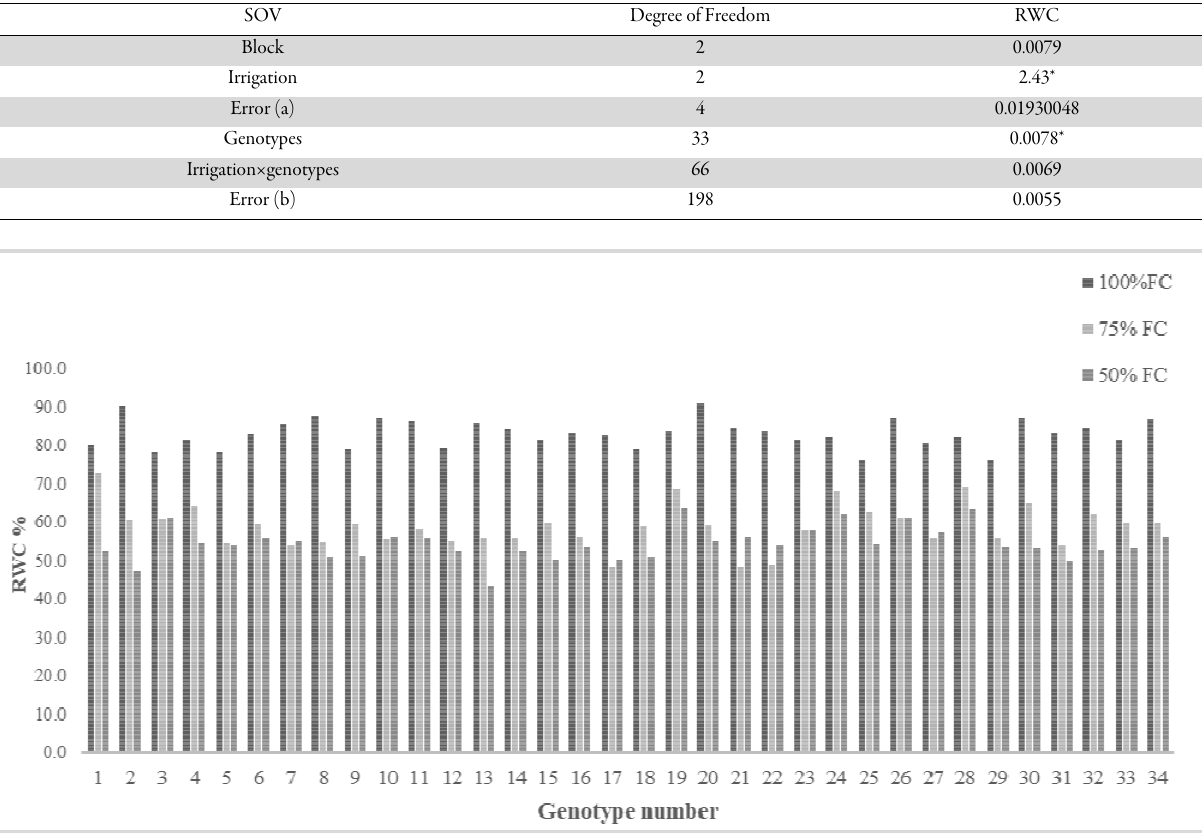
Table 3. Statistical significance of the source of variations in analysis of variance for RWC of 36 hexaploid wheat genotypes under non-stress (NS, 100% FC) and stress (75 and 50% FC) conditions